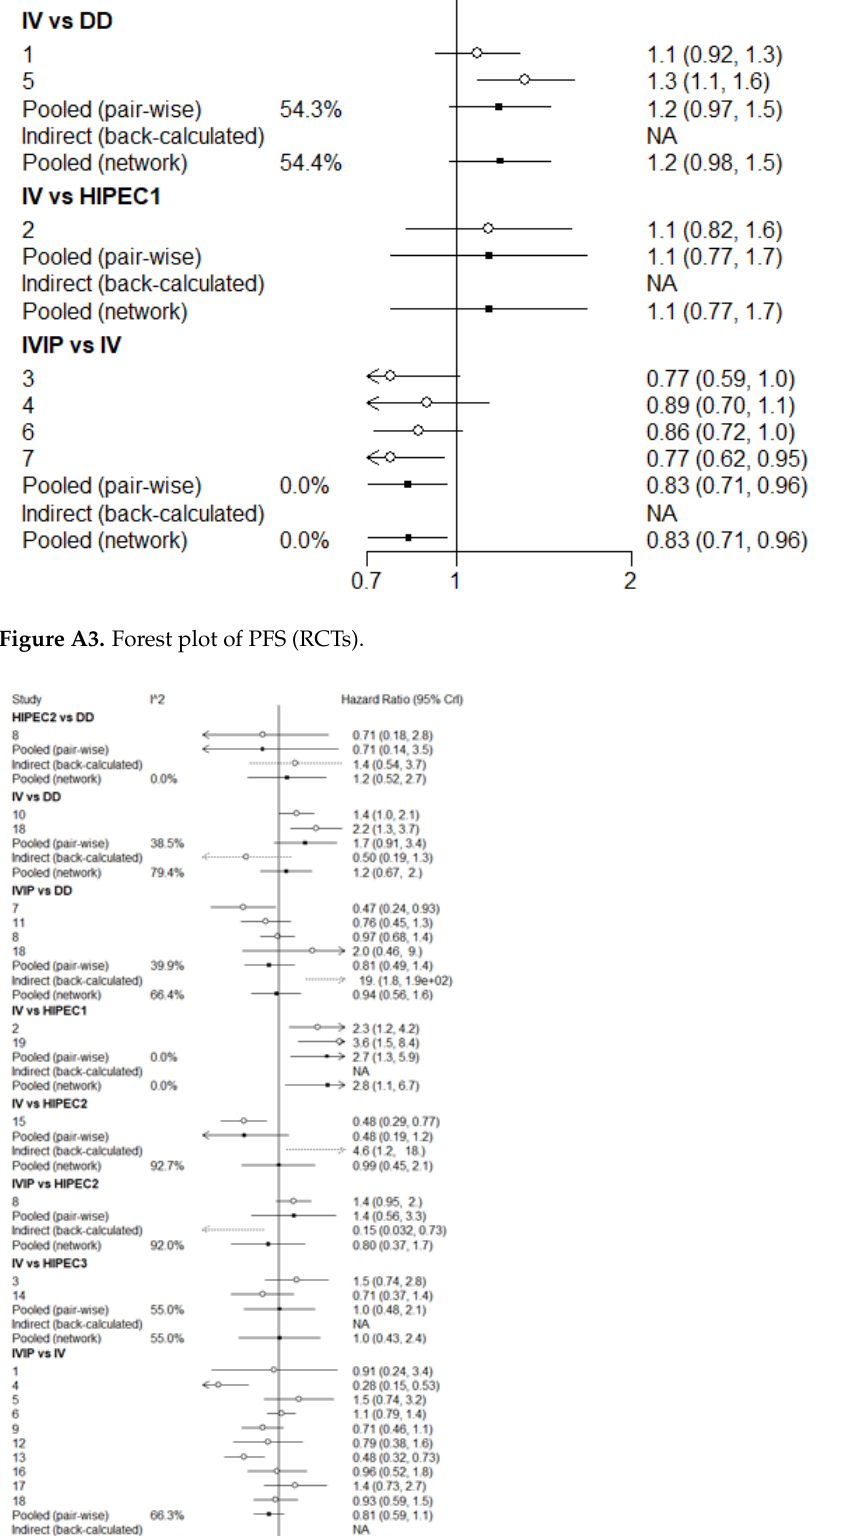
Figure A4. Forest plot of PFS (non ‐ RCTs).